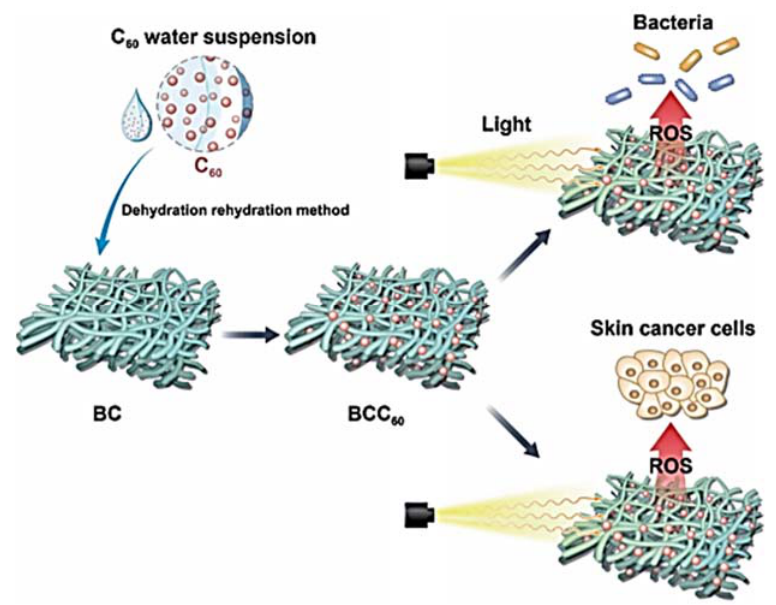
Figure 8. Physical de-hydration method for inclusion of photosensitiser C 60 in BC for photodynamic therapy in cancer treatment. Reprinted with permission from [136]. Copyright (2018) The Royal Society of Chemistry.